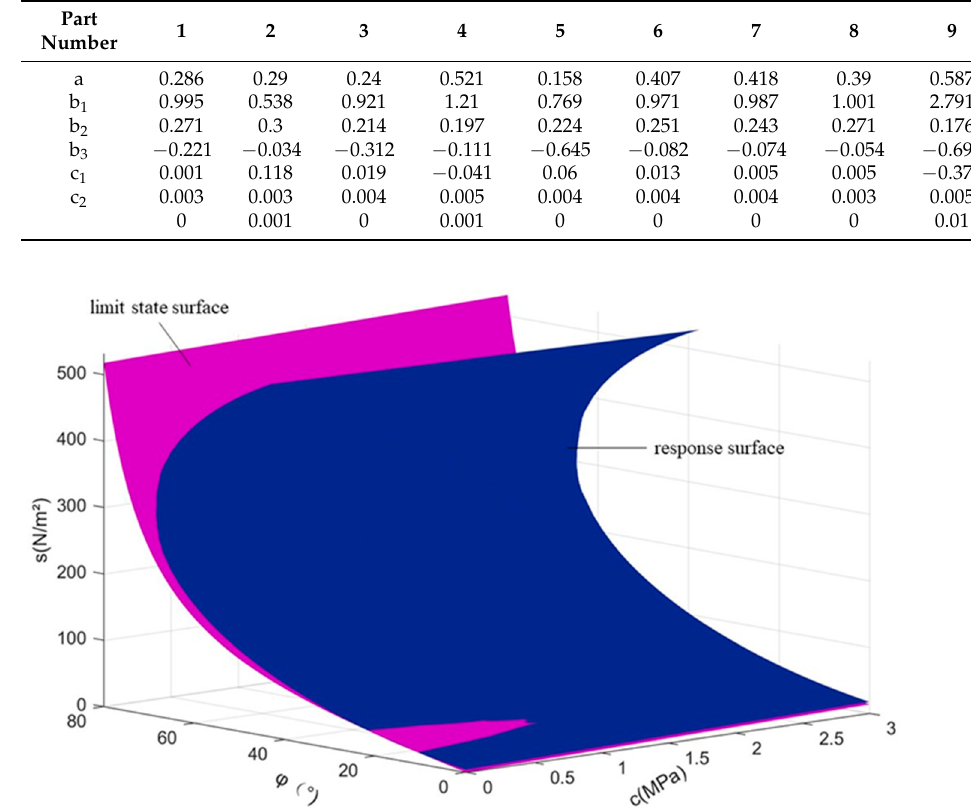
Figure 4. Limit state surface of part 1 when λ =